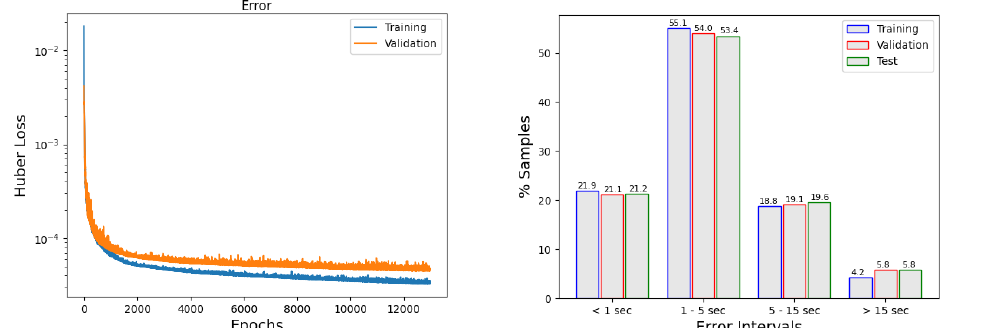
Figure 10. Train and validation error during training ( left ) and percentage of predictions in certain error intervals in the arrival times problem ( right